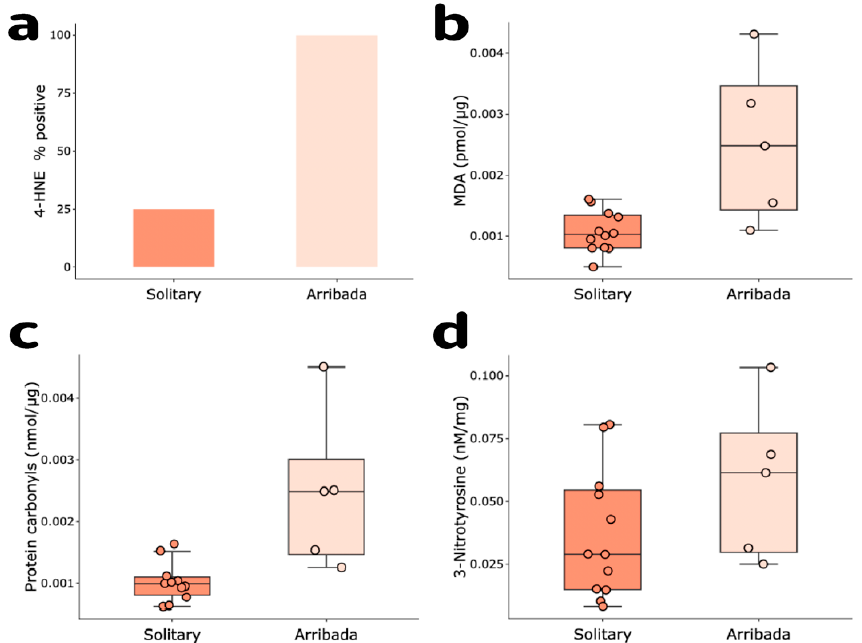
Figure 5. Oxidative damage. Lipid peroxidation products: ( a ) 4-HNE-protein adducts (binary test, percent positive arribada, 100% vs. solitary, 25%, p = 0.0009, χ 2 (2) = 10.01, p = 0.0016), and ( b ) MDA- protein adducts ( p = 0.0019); ( c ) protein carbonyls ( p = 0.0027) and ( d ) 3-Nitrotyrosine ( p = 0.22).